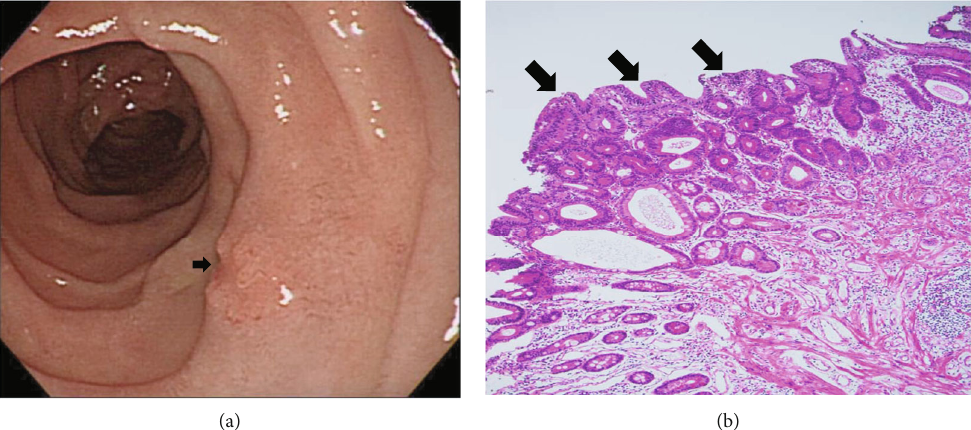
Figure 5: (a) Ulcerated lesion over the infrapapillary area (arrow). (b) Mucosal glands of the duodenum with focal low-grade dysplasia (arrow) (H&E,